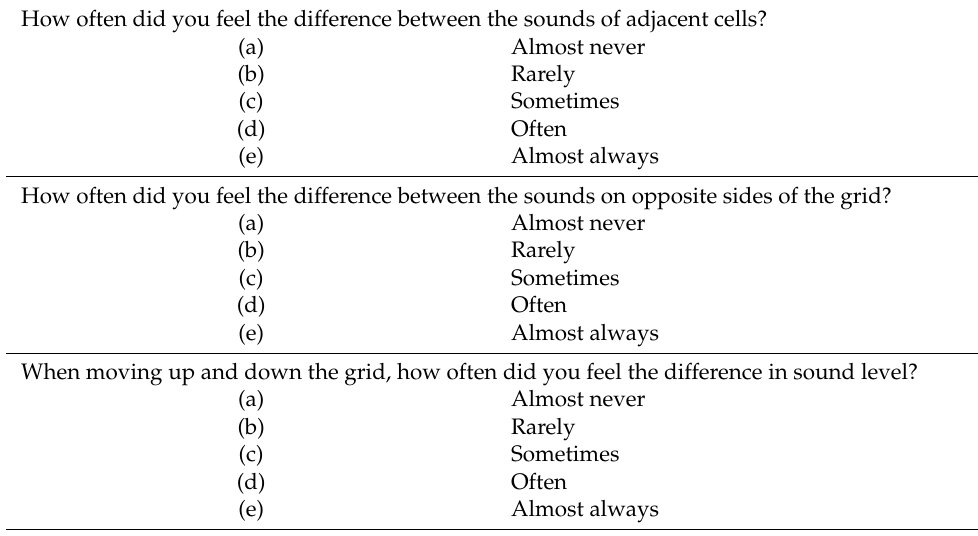
Table A1. Self-Fitting Prototype (SFP)